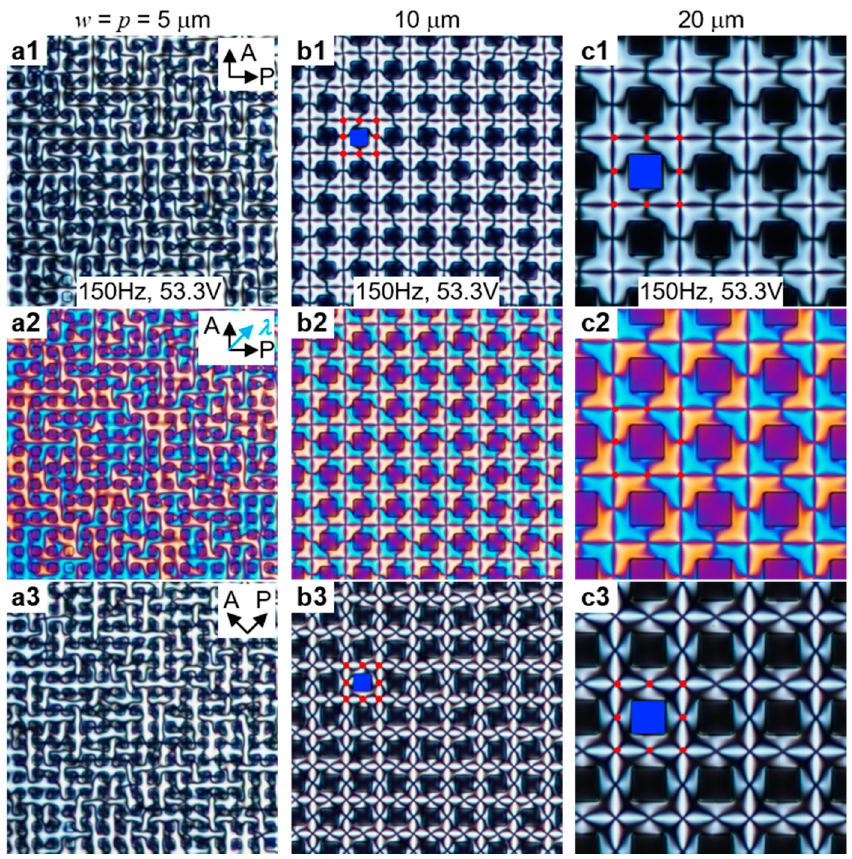
Figure 5. Defect array formation in square-shaped pillars with width w and spacing p of pillars observed by polarizing optical microscopy: ( a ) w = p = 5 µ m; ( b ) w = p = 10 µ m; and ( c ) w = p = 20 µ m. ( a1 – c1 ) Under crossed polarizers in the orthogonal direction; ( a2 – c2 ) with a full-wave plate; and ( a3 – c3 ) in the diagonal direction. Pillar height is h = 2 µ m and cell thickness is d = 5.6 µ m. P, polarizer; A, analyzer; λ , full-wave plate. The red dots are umbilical defects; the blue square represents